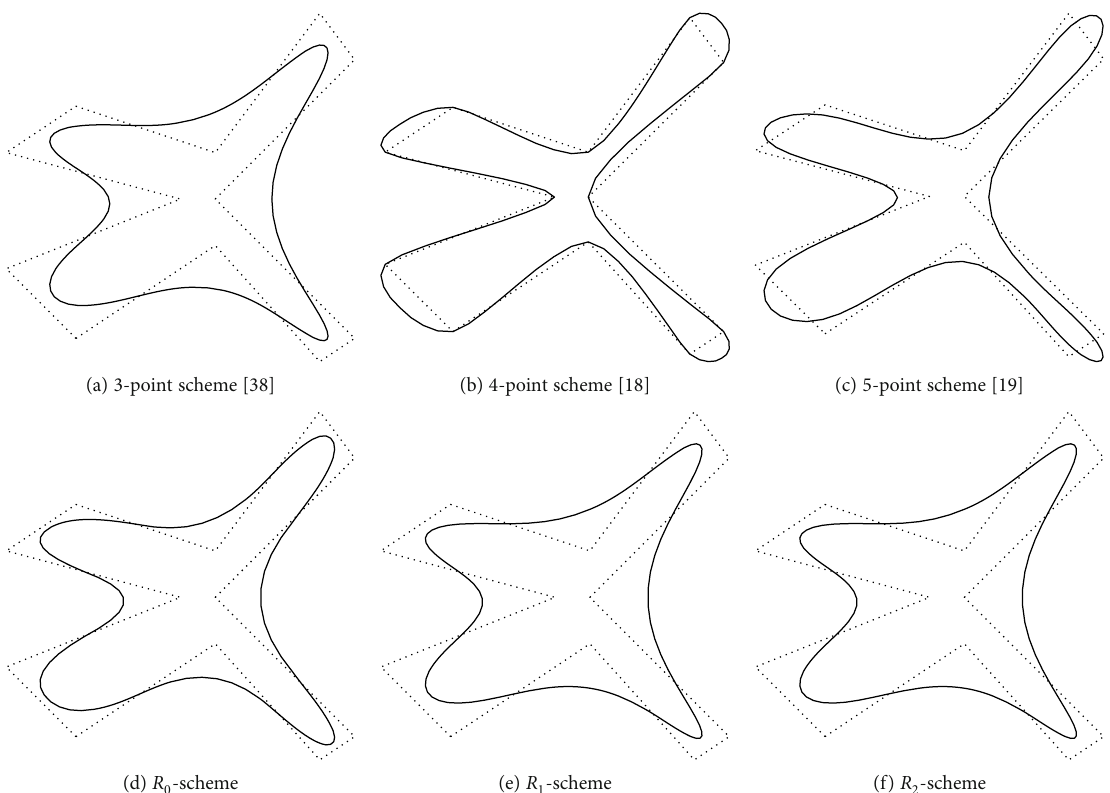
Figure 11: Comparison of the existing and proposed subdivision schemes at the third subdivision